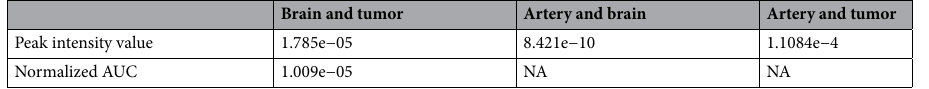
Table 3. p value table for all paired t-tests, for both peak intensity and normalized